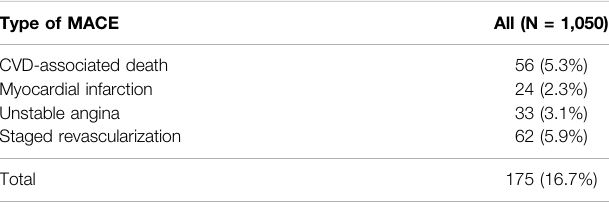
TABLE 3 | Types of